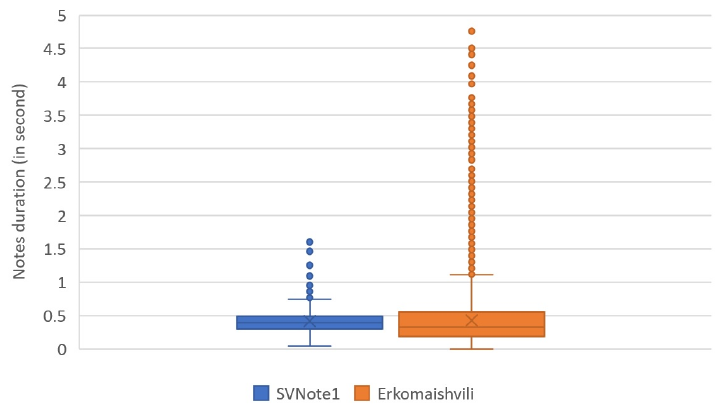
Figure 6. Box and whisker of the estimated notes’ duration in the SVNote1 and the Erkomaishvili datasets.